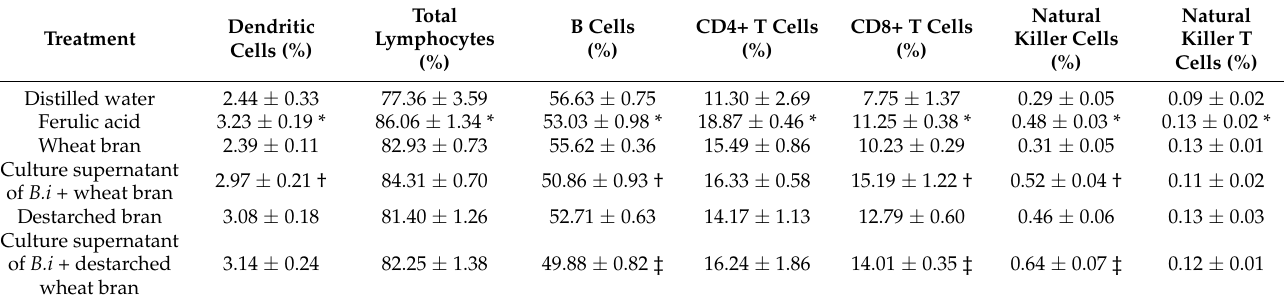
Values represent the percentage of total cells and are expressed as the mean + standard errors of the mean. N = 3 mice. Statistical analysis by Mann–Whitney U test. * p < 0.05 vs. distilled water; † p < 0.05 vs. wheat bran; ‡ p < 0.05 vs. destarched bran. B.i , Bacteroides intestinalis. Table 3. Spleen cells in each group of mice.